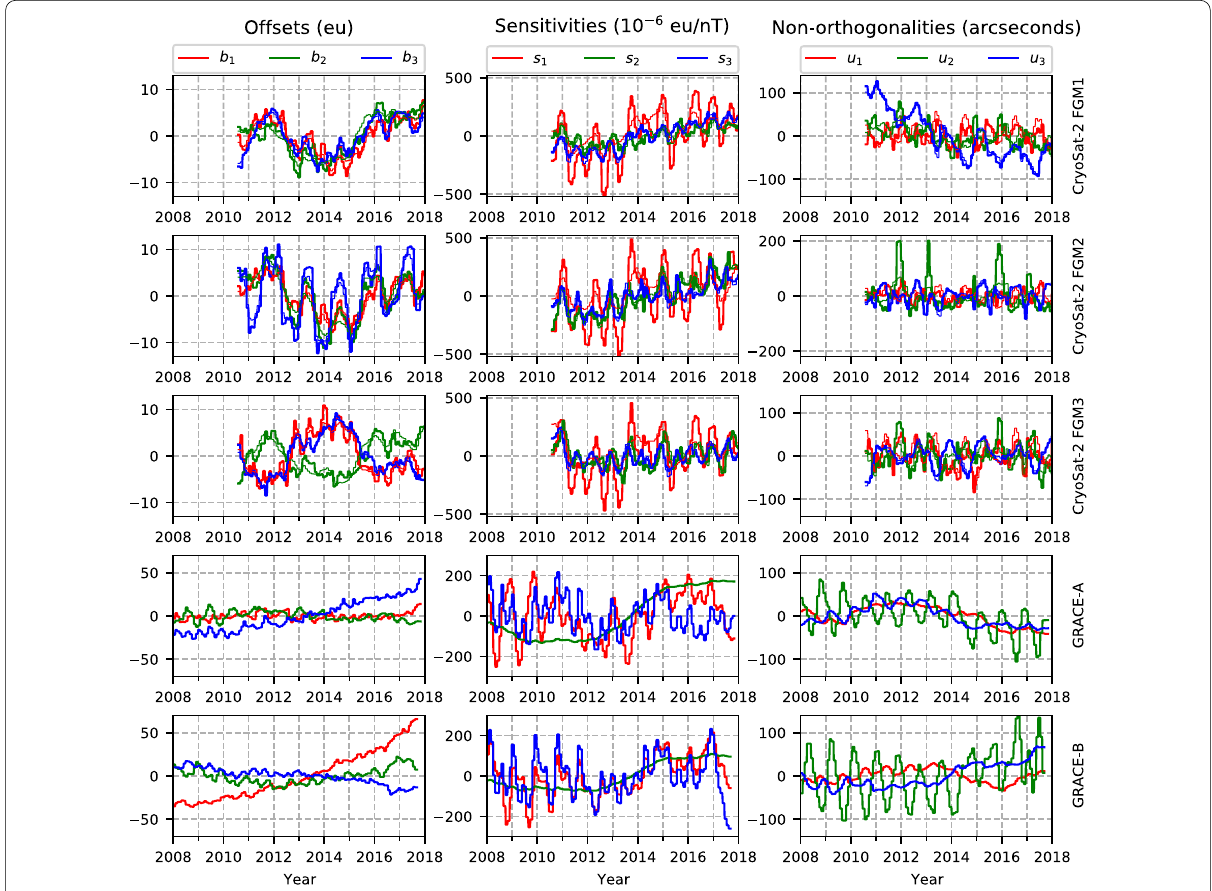
Fig. 5 Time-series of the calibration parameters of Model-B for each platform magnetometer dataset (thick lines) and calibration parameters of Olsen et al. (2020) for CryoSat-2 (thin lines). The respective mean values in time were removed and are shown in Table 7